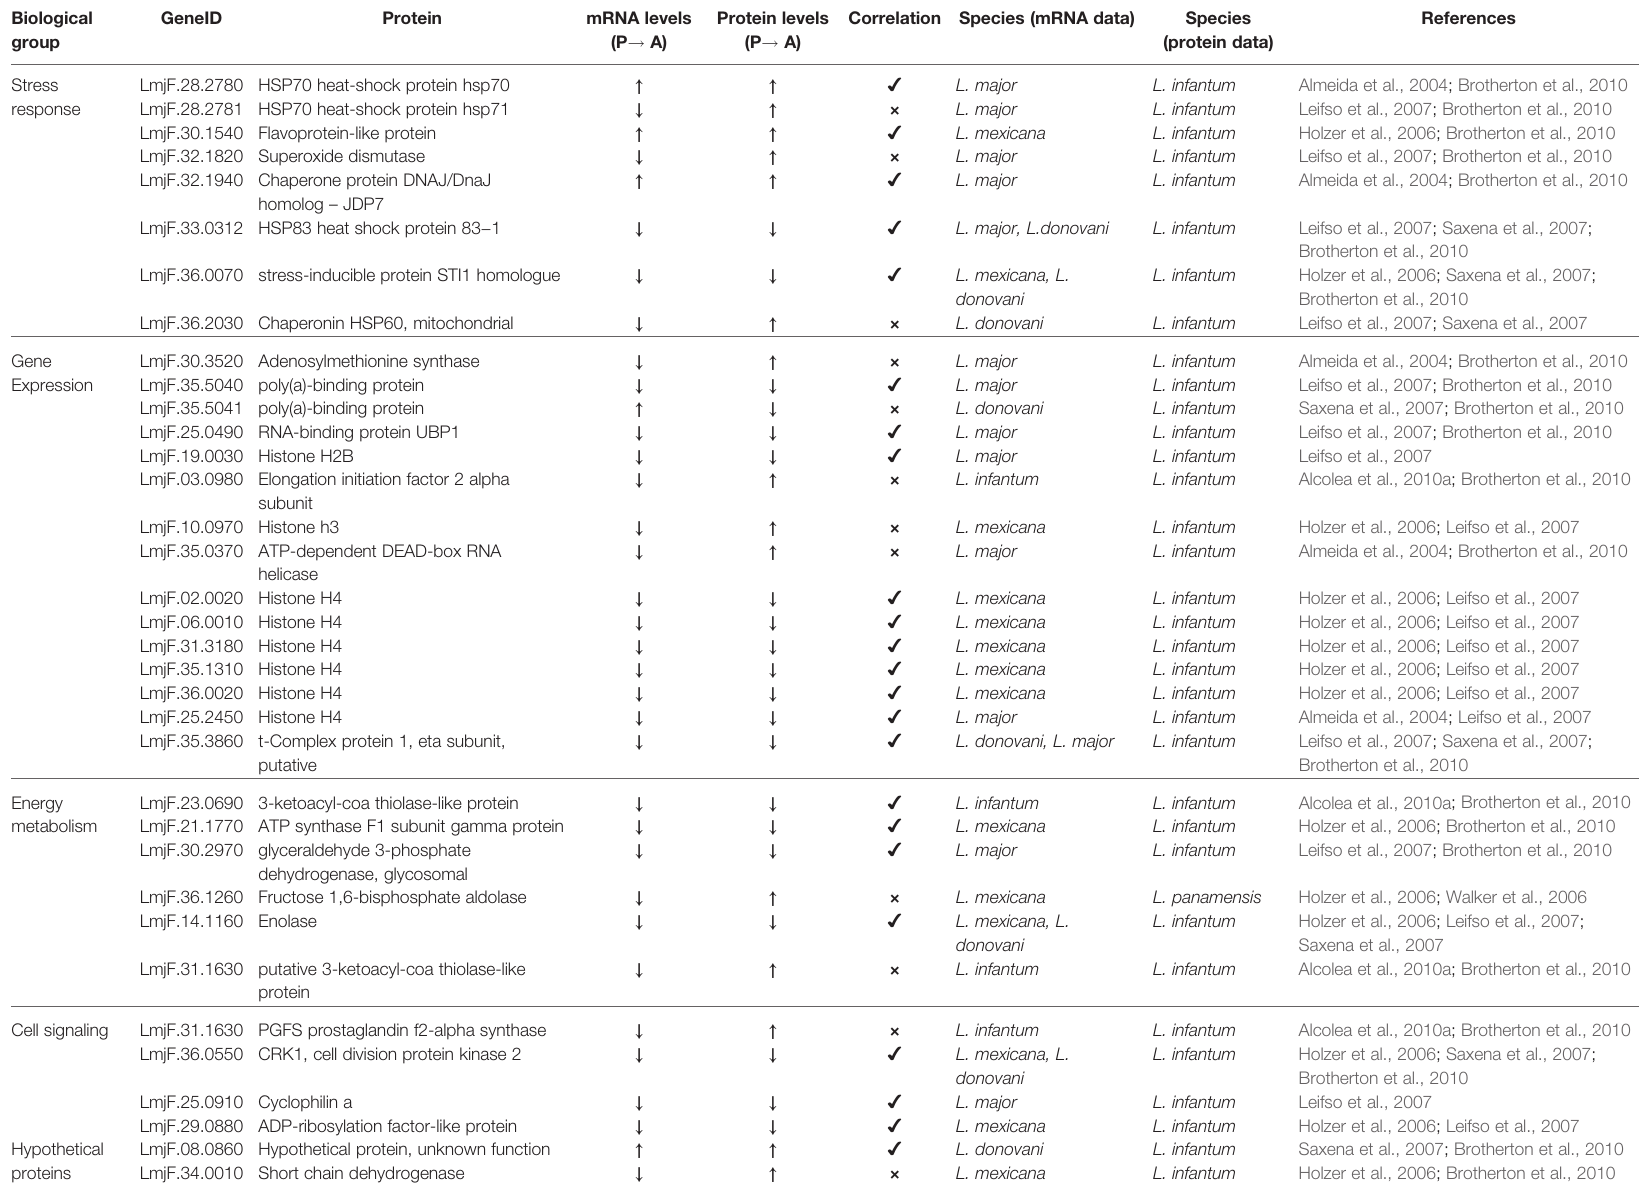
TABLE 2 | Common genes found in independent transcriptomic and proteomic data obtained from amastigogenesis (promastigote vs. amastigote) differentiation. Biological